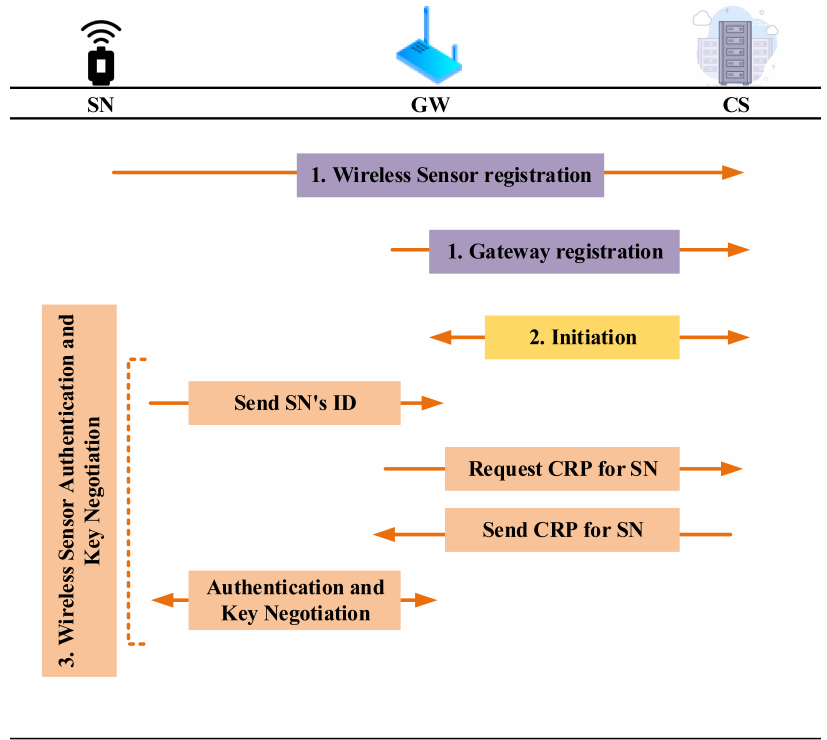
Figure 2. Protocol communication